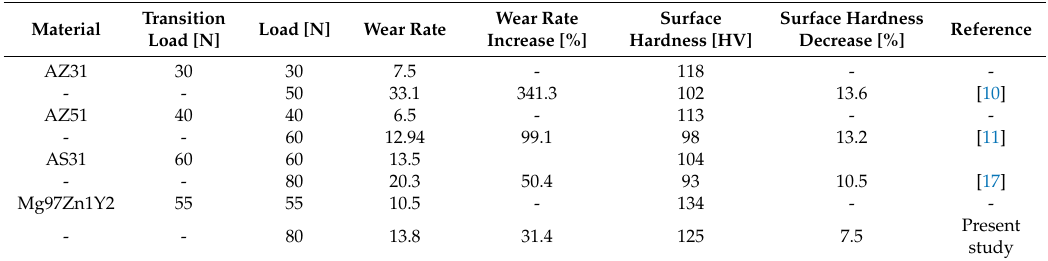
Figure 6. SEM morphologies of worn surfaces of Mg97Zn1Y2 alloy at sliding speed of 0.3 m/s and 4.0 m/s and different applied loads: ( a ) 20 N, ( b ) 60 N, ( c ) 100 N, ( d ) 180 N, ( e ) 260 N, ( f ) 140 N, 4 m/s. Table 2. Comparison of changes in wear rate and surface hardness between AZ, AS31 and Mg97Zn1Y2 alloys after mild-severe wear